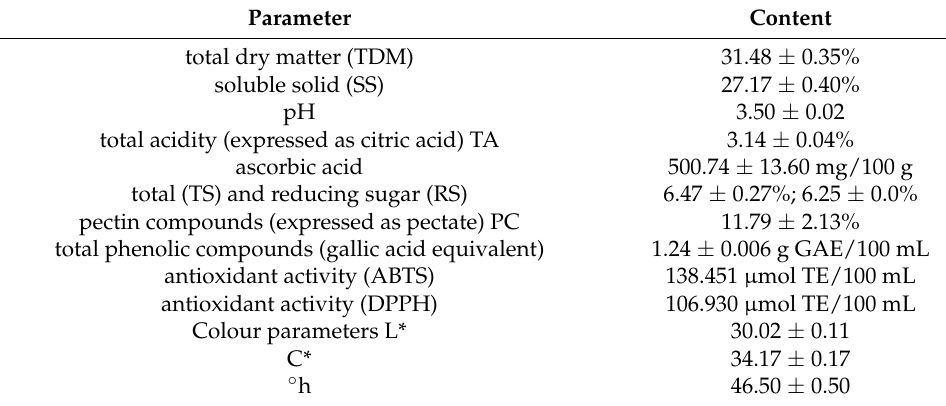
Table 1. Characteristics of rose hip